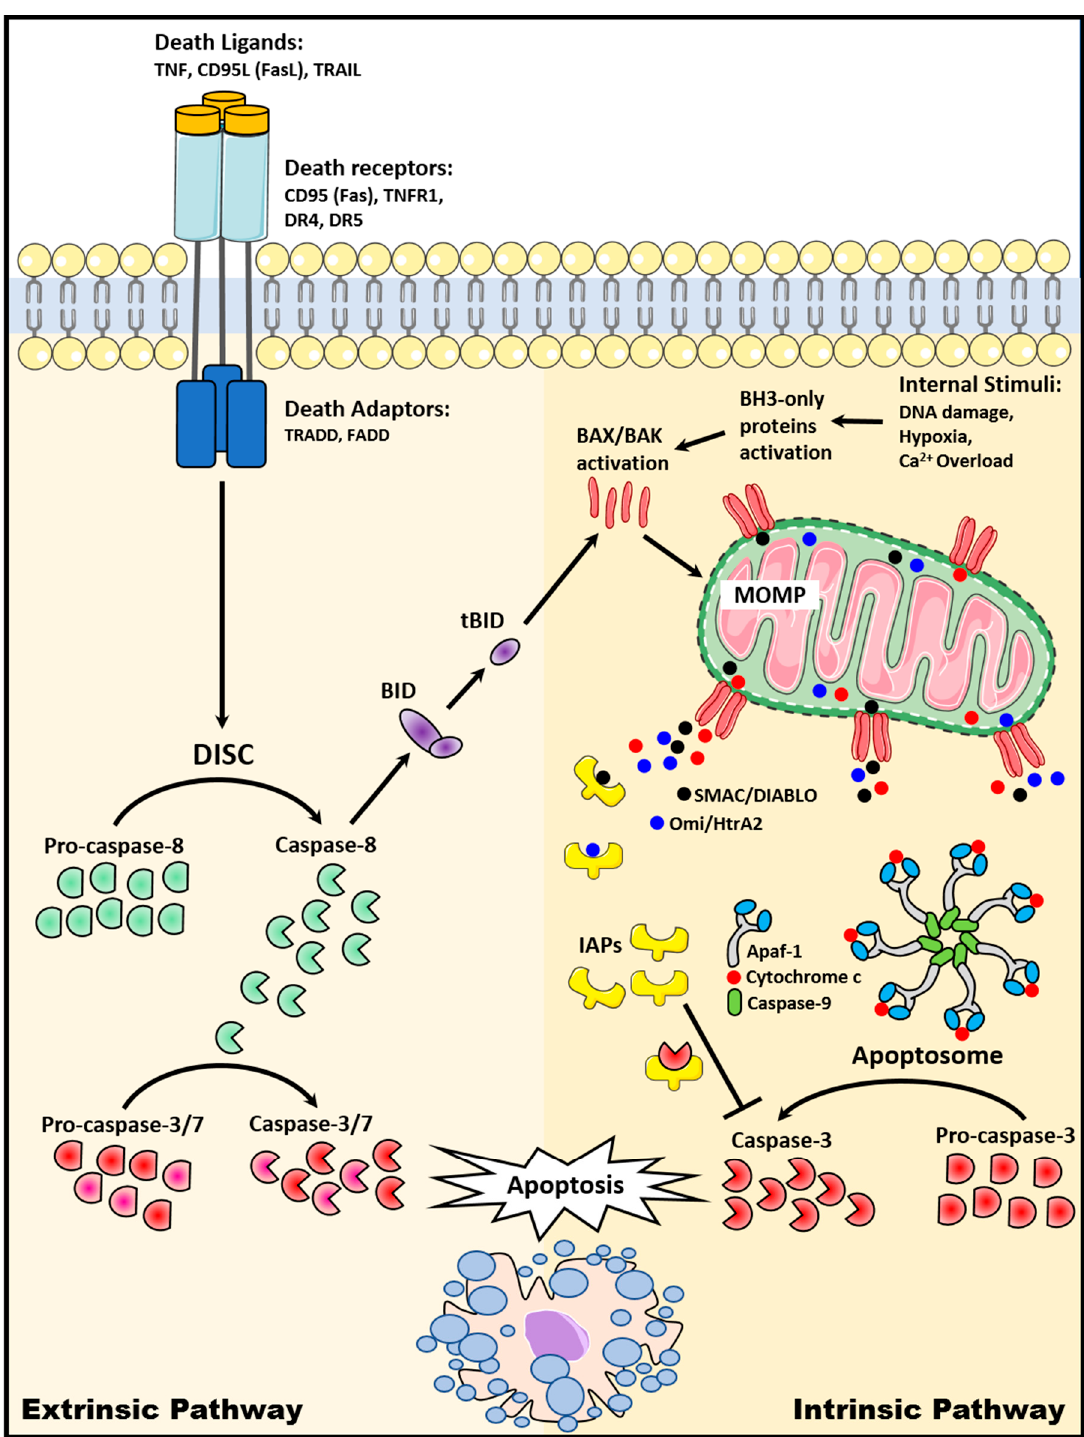
Figure 1. Extrinsic and intrinsic apoptosis signaling pathways.